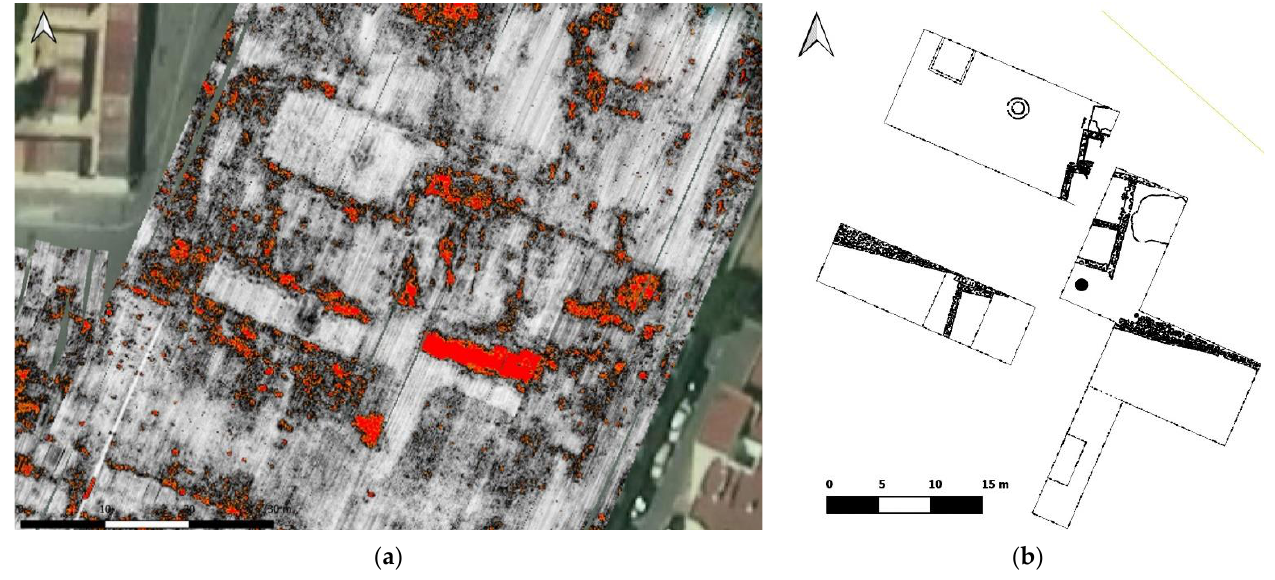
Figure 21. (a) Detailed view of the central part of the study area showing the different alterations of Set 3 at -0.89 m. (b) Plan of the archaeological soundings carried out in the central part of the study area in 2004 showing the documented structures [42] (p. 23).